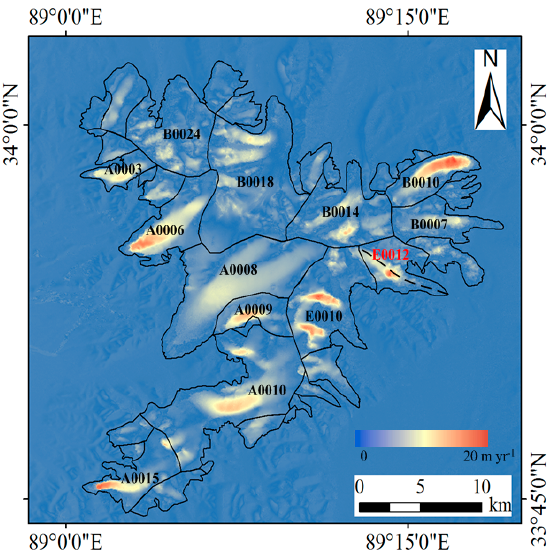
Figure 6. Glacier surface velocity in line ‐ of ‐ sight direction of the Puruogangri ice field in 2009. The letter and numbers are the last five codes of the glacier WGMS IDs. The glacier outlines are shown in solid black, and the dashed black line is the central flow line of glacier 5Z213E0012.